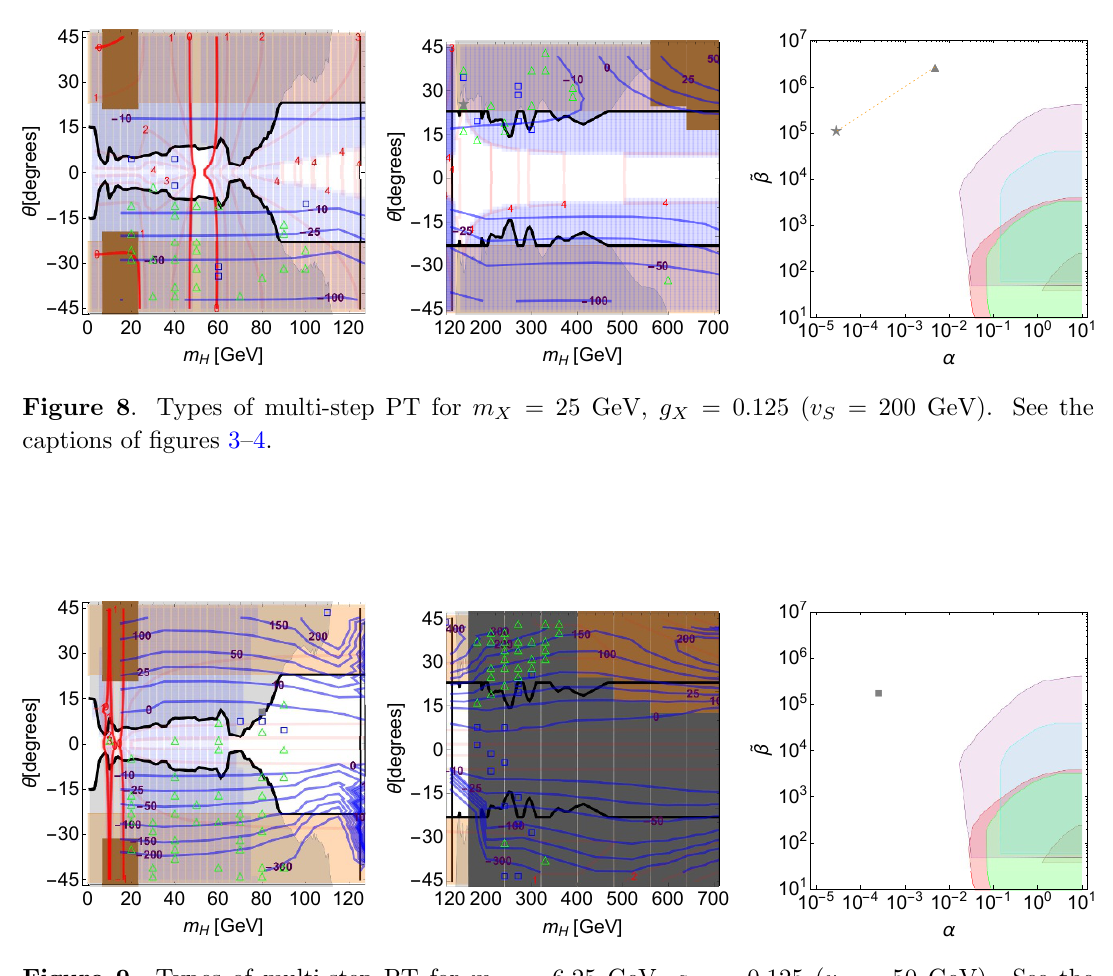
Figure 9 . Types of multi-step PT for m X = 6 . 25 GeV, g X = 0 . 125 ( v S = 50 GeV). See the captions of figures